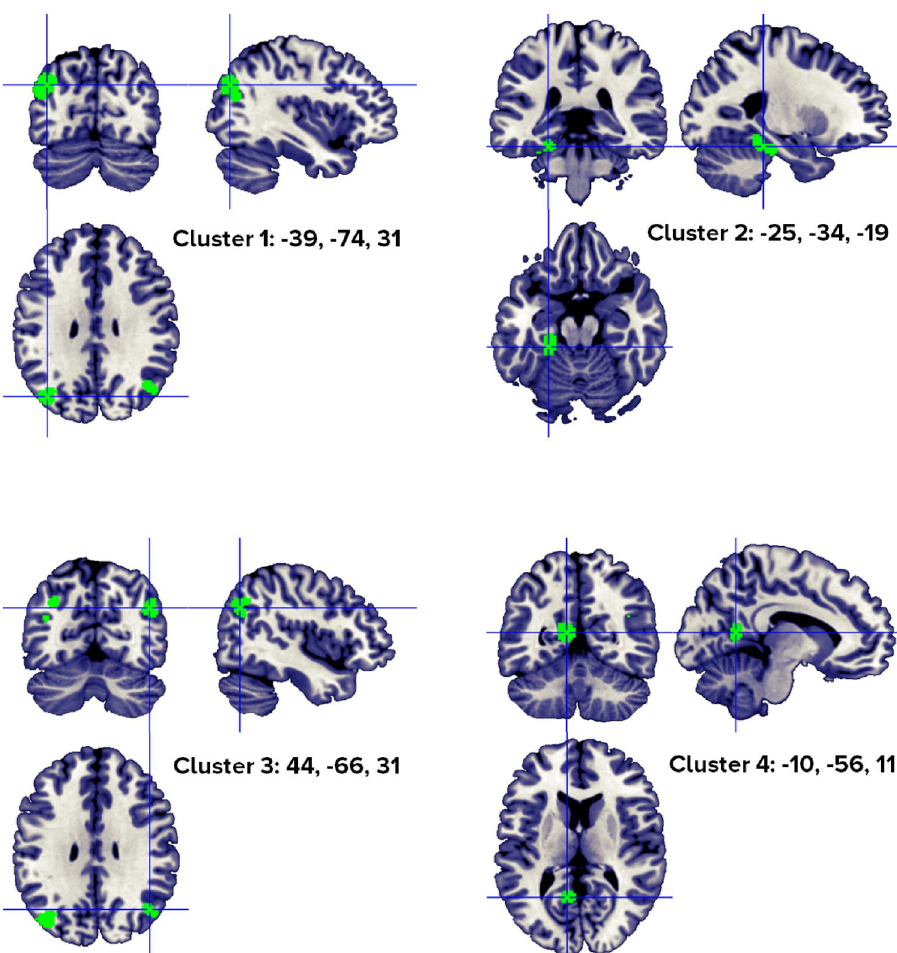
Figure 5. Clusters activated by the concrete > abstract words -semantic and lexical tasks—contrast. The crosses are centered in the areas correspond to stereotactic coordinates reported in Table 5. The images are presented in neurological